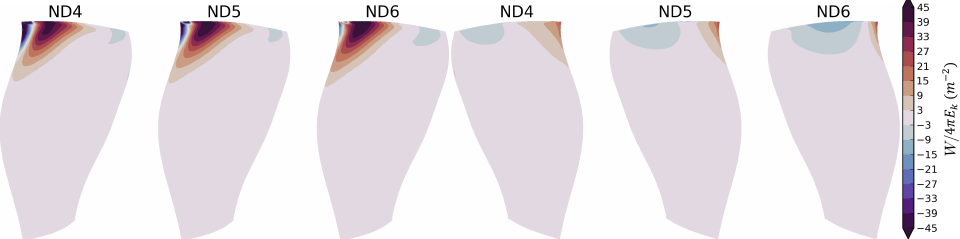
Figure 20. Local work at OP-E for Modes 2ND4 to 2ND6: ( left three blades ) suction side; ( right three blades ) pressure